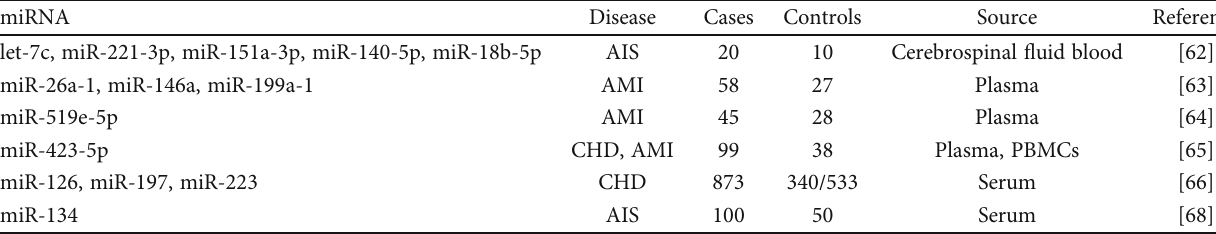
Table 1: miRNAs associated with I/R injury as a clinical biomarker of ischemic diseases.